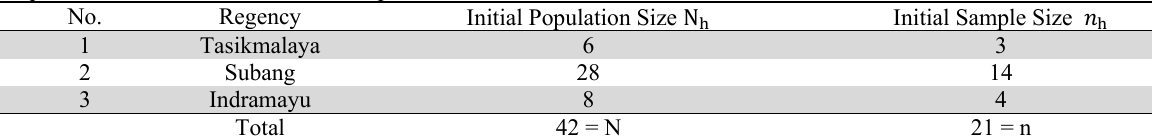
Sample Size Distribution of the Initial